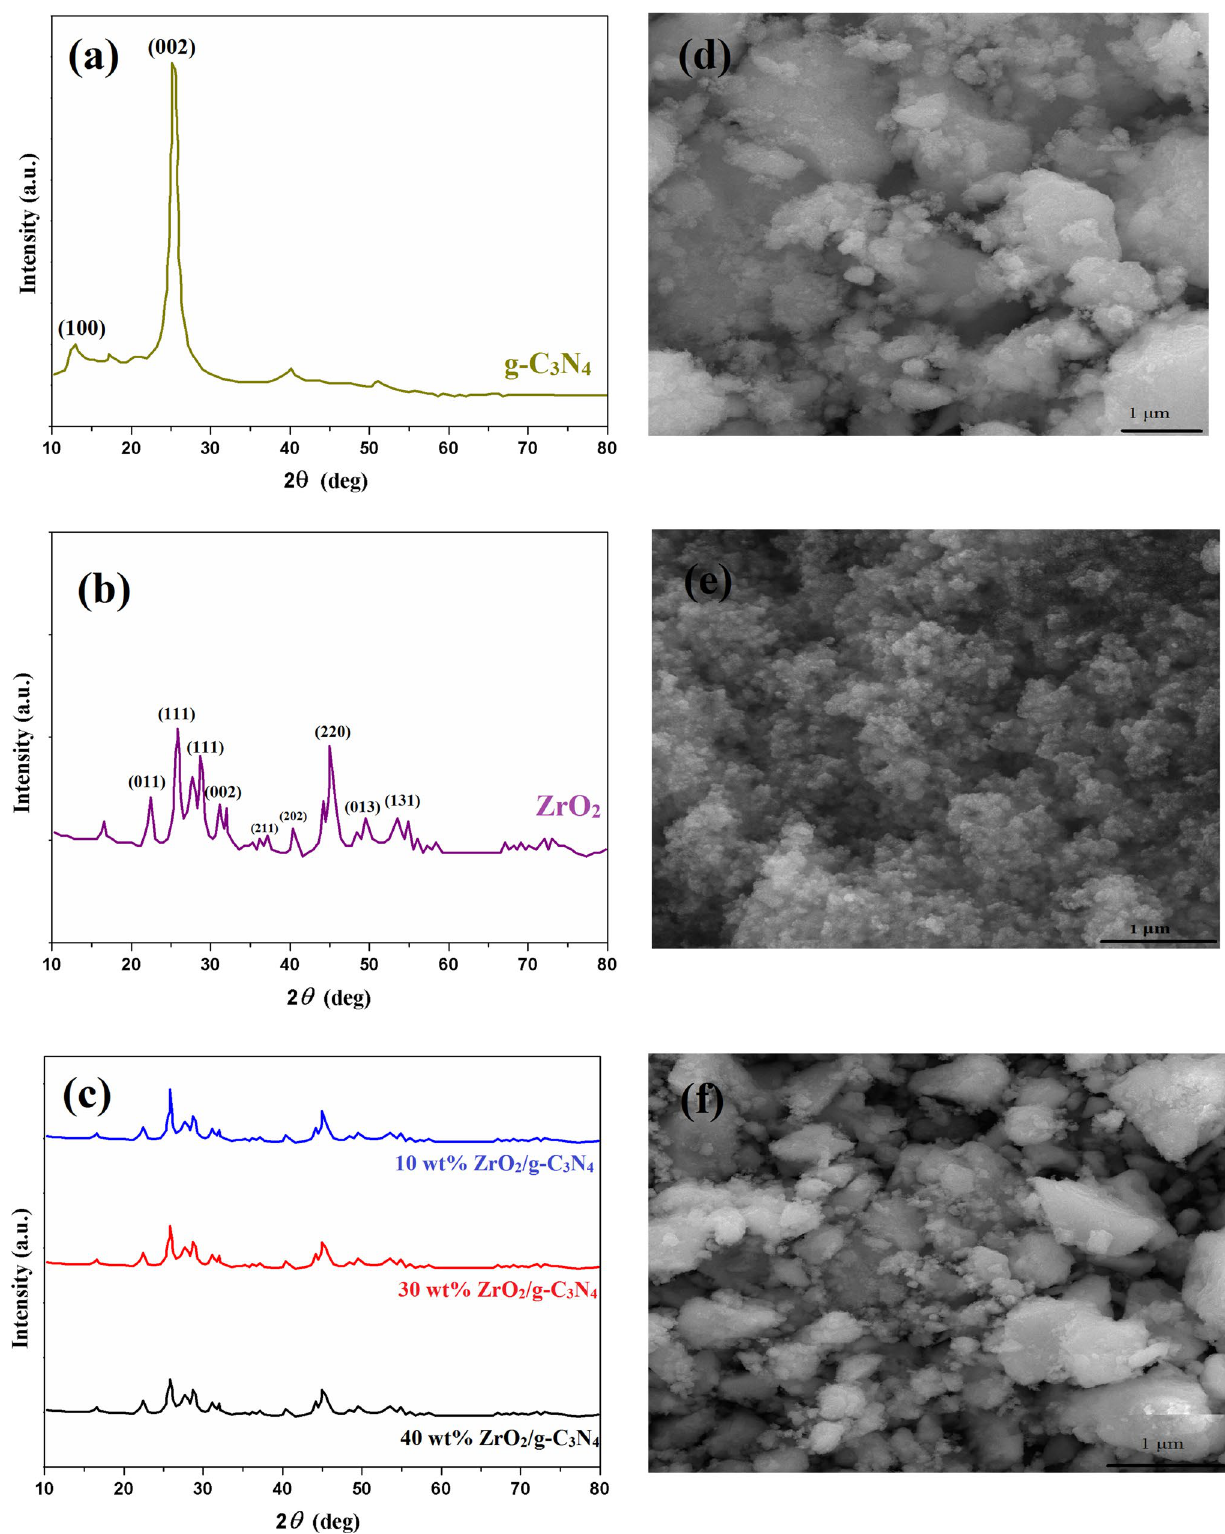
Fig. 1 XRD patterns of a g-C 3 N 4 , b ZrO 2 and c ZrO 2 /g-C 3 N 4 com- posites with different